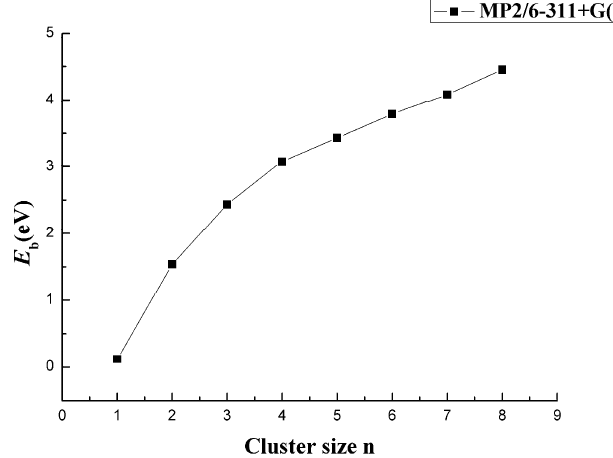
Molecules 2019 , 24 , x FOR PEER REVIEW Figure 7. Size dependence of the average binding energy of CaB n (n = 1–8) clusters.